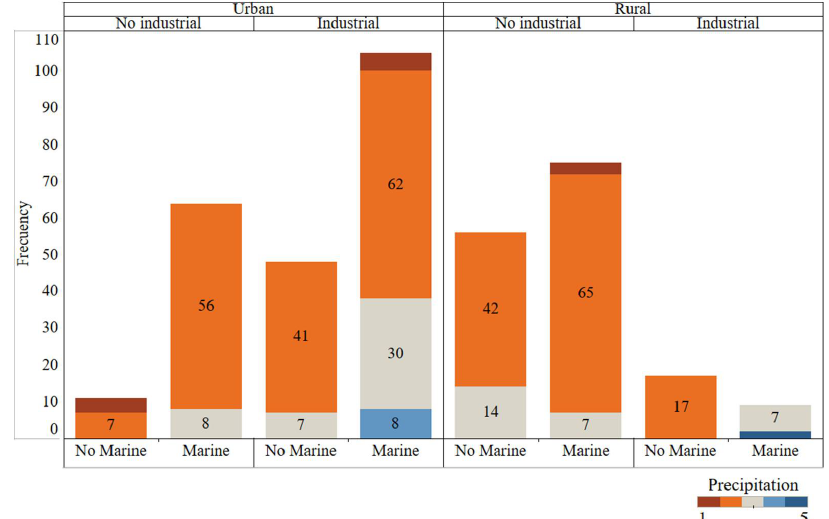
Figure 3. Frequency graphical analysis of the categorical variables. All possible atmospheric environment combinations are represented and coloured by precipitation type.